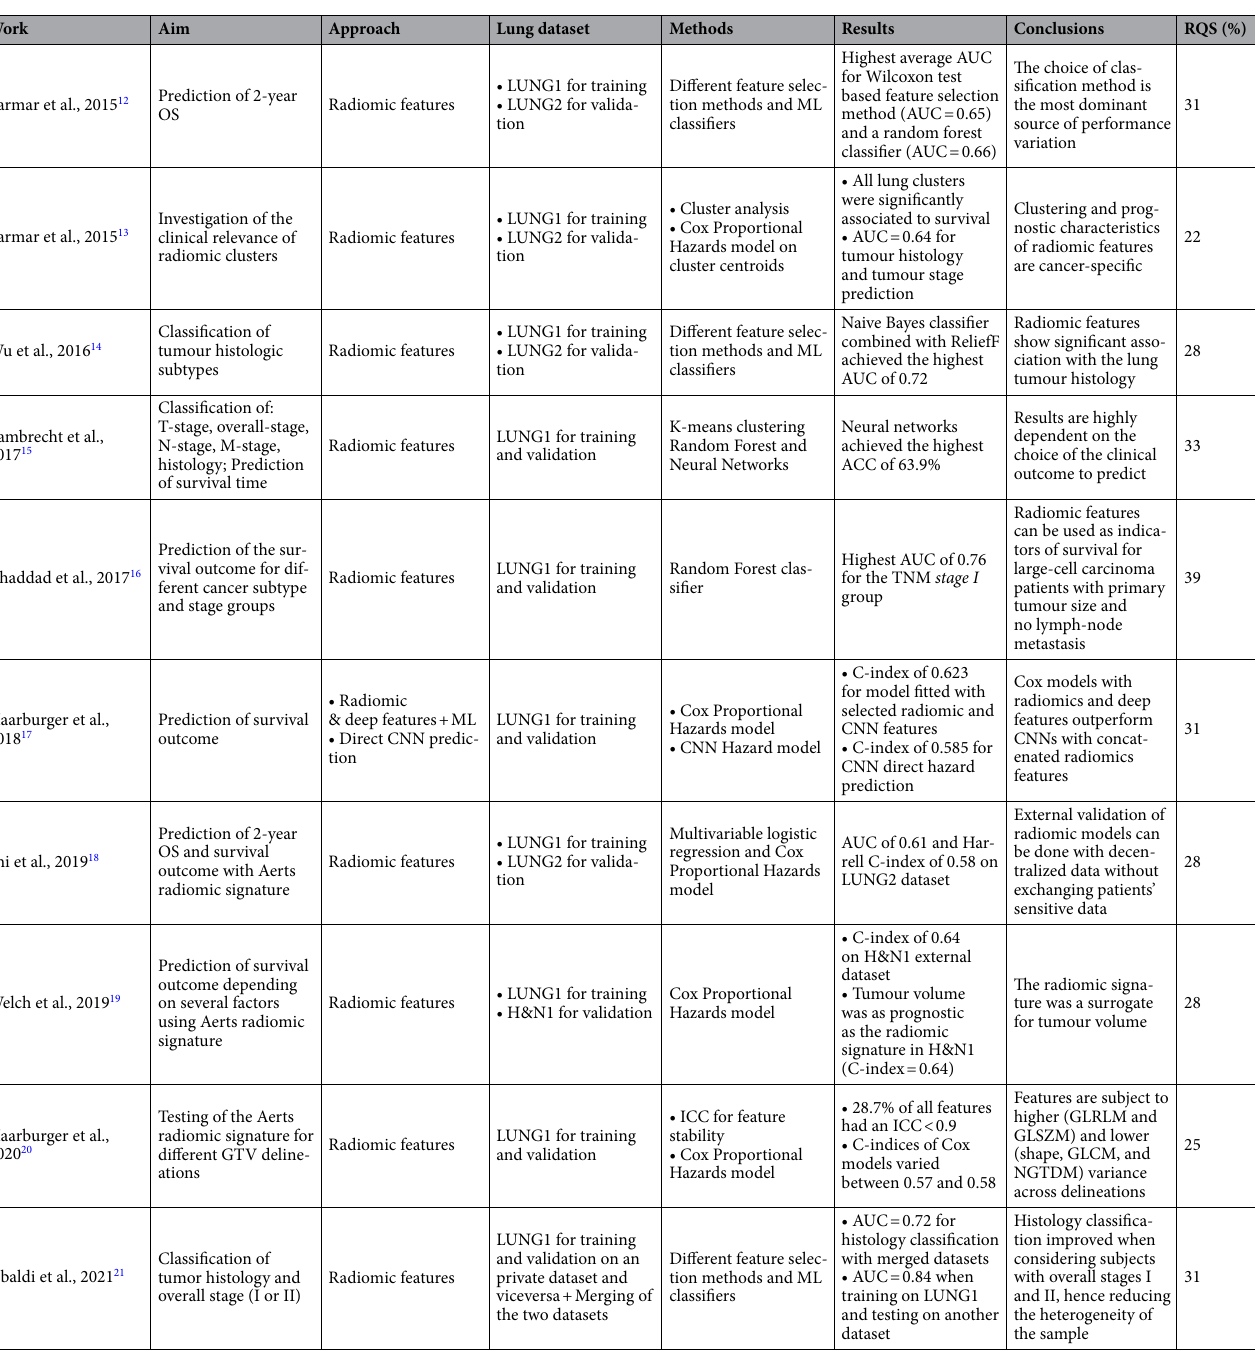
Table 1. Summary of previous studies based on LUNG1 public dataset. ACC accuracy, AUC area under the receiver operating characteristic curve, C-index concordance index, CNN convolutional neural network, GLCM grey level co-occurrence matrix, GLRLM grey level run length matrix, GLSZM grey level size zone matrix, ICC intra-class correlation coefficient, ML machine learning, NGTDM neighboring grey tone difference matrix, OS overall survival, RQS radiomic quality